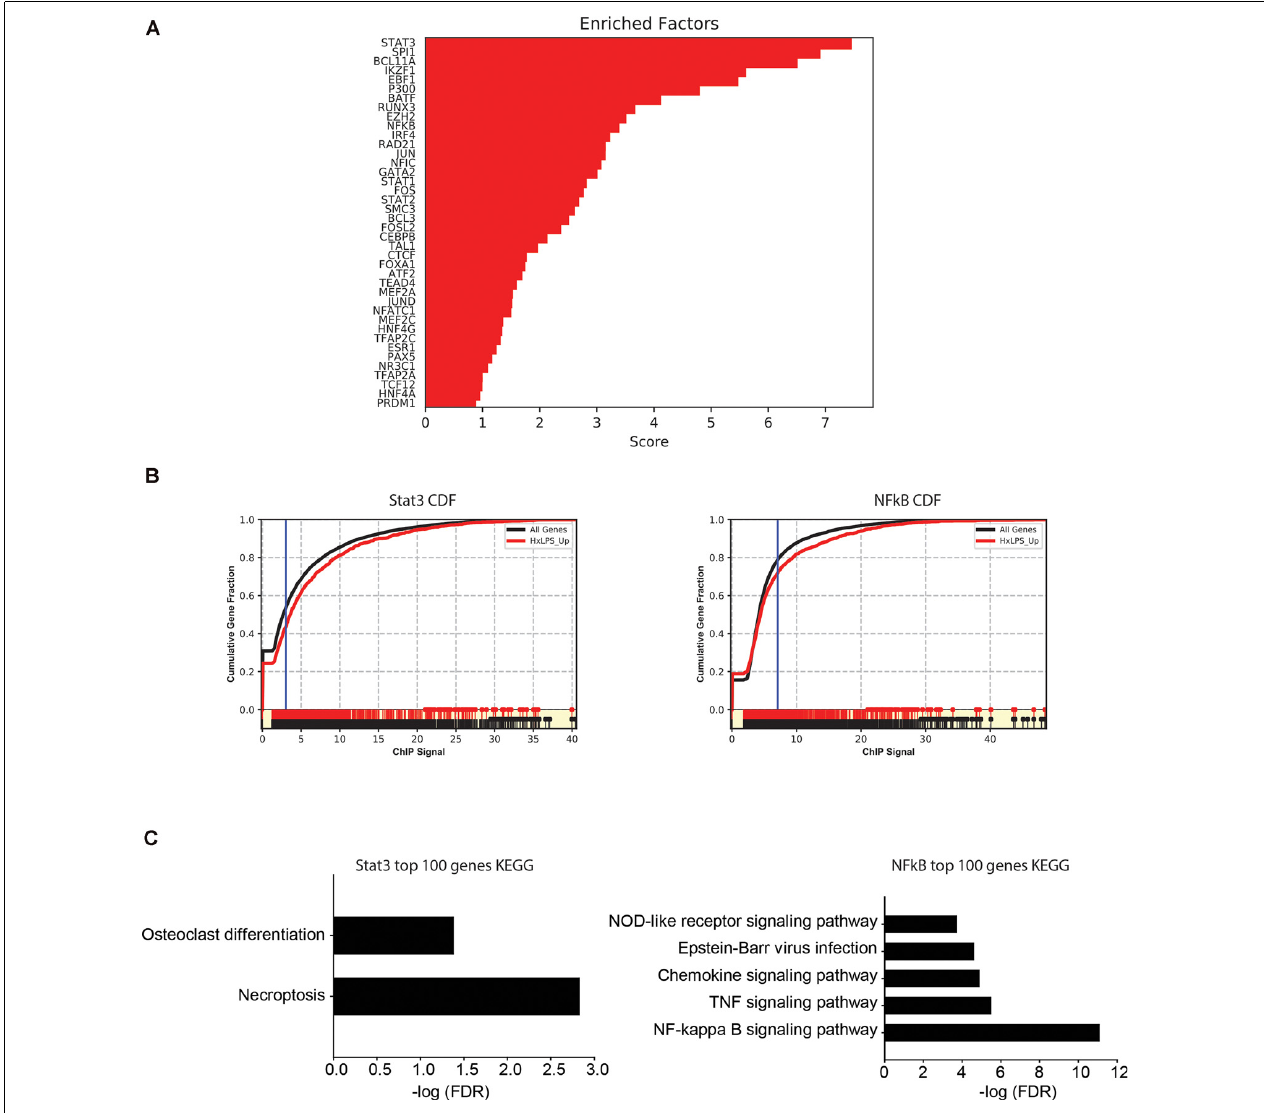
FIGURE 7 | MAGICTRICKS analyses reveal multiple putative transcription factors that bind at “primed” genes. (A) MAGICTRICKS summary output for Hx primed genes. (B) Cumulative distribution functions for the transcription factors Stat3 (left) and NF- κ B (right). (C) Target genes for Stat3 or NF κ B that were identified using MAGICTRICKS were sorted by the ChIP score (highest to lowest), and the top 100 genes were examined using KEGG Pathway analyses. Different KEGG categories were enriched with Stat3 genes (left) vs. NF- κ B genes (right). Results are derived from n = 3 biological